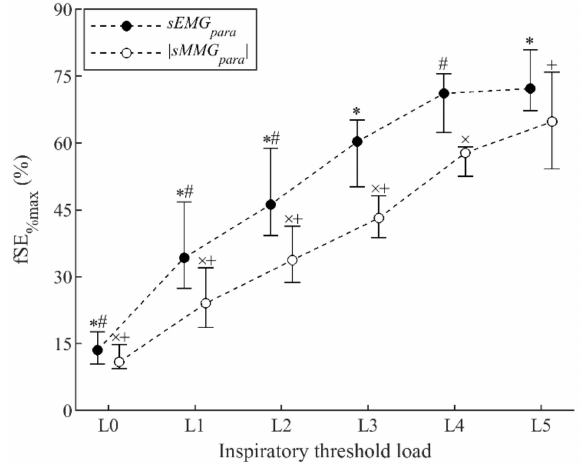
Figure 3. Fixed sample entropy measurements of surface mechanomyography (fSE|sMMG para | %max ) and surface electromyography (fSEsEMG para%max ) of the parasternal intercostal muscles during inspiratory threshold loading. Data points represent median and interquartile range of the 12 subjects for each load. All data points with the same symbol (*, #, × , or +) were significantly different to each other.